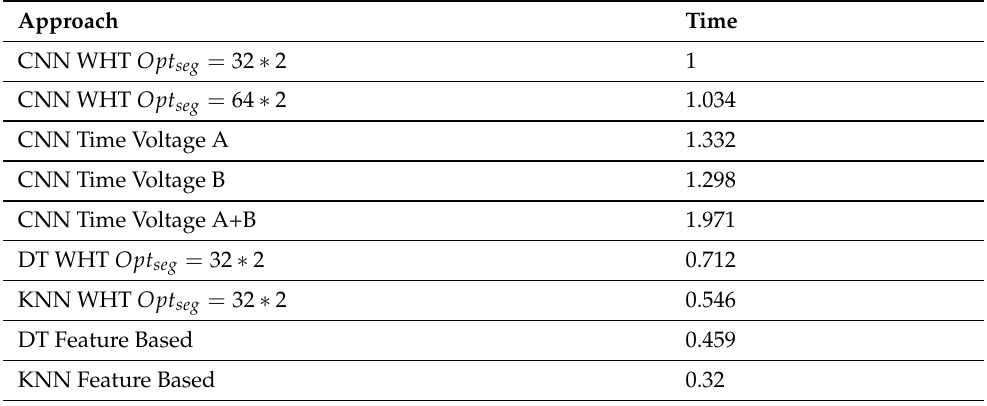
Table 3. Comparison of the computing time among the different